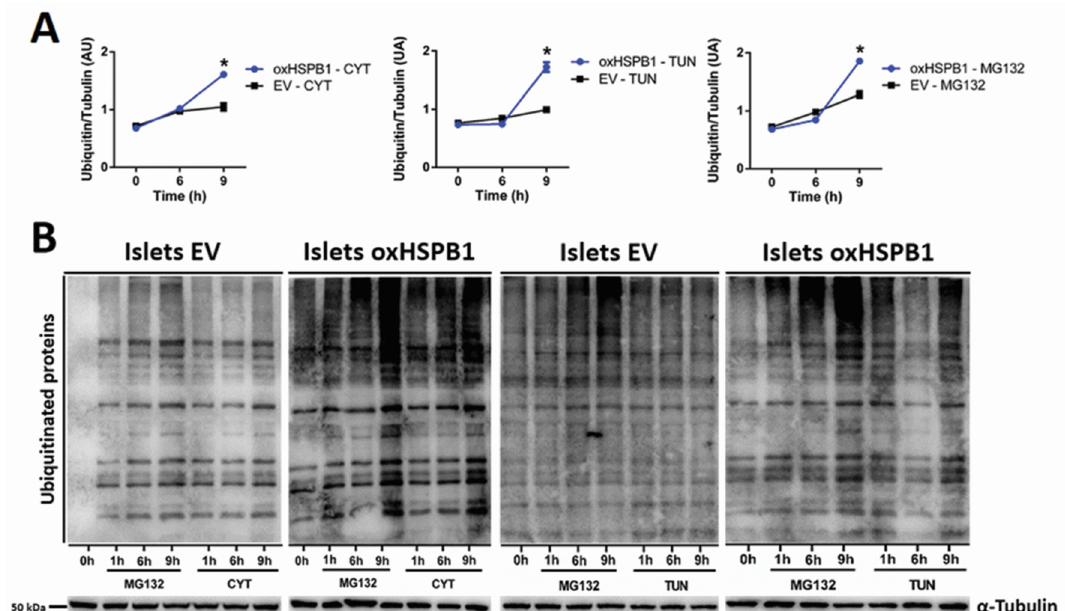
Figure 4. HSPB1 overexpression leads to increased global protein ubiquitination. Mouse islets overexpressing HSPB1 (oxHSPB1) and the respective controls (EV) were serum-starved and then exposed to a combination of cytokines (TNF α 8 ng/mL, IFN γ 16 ng/mL, IL-1 β 1.6 ng/mL), tunicamycin (7.5 µ g/mL), or MG132 (2 µ M) for 6 and 9 h. ( A ) Graphical representation of ubiquitinated proteins results presented as arbitrary densitometry units (AU) after normalization by their respective α -tubulin contents. ( B ) Representative images of immunoblots showing the levels of ubiquitinated proteins of islets treated with cytokines and tunicamycin. Each data point represents the mean ± SEM from three replicates and at least three independent experiments carried out for each cell type submitted to the different cell incubation conditions; * p < 0.05 vs. EV.